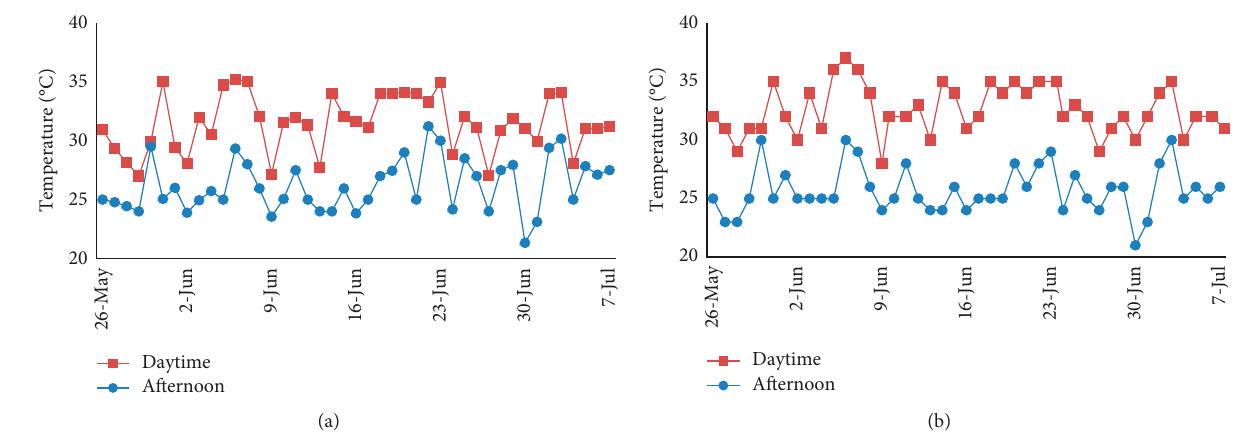
Figure 1: Graph of temperature: (a) room temperature and (b) soil temperature.